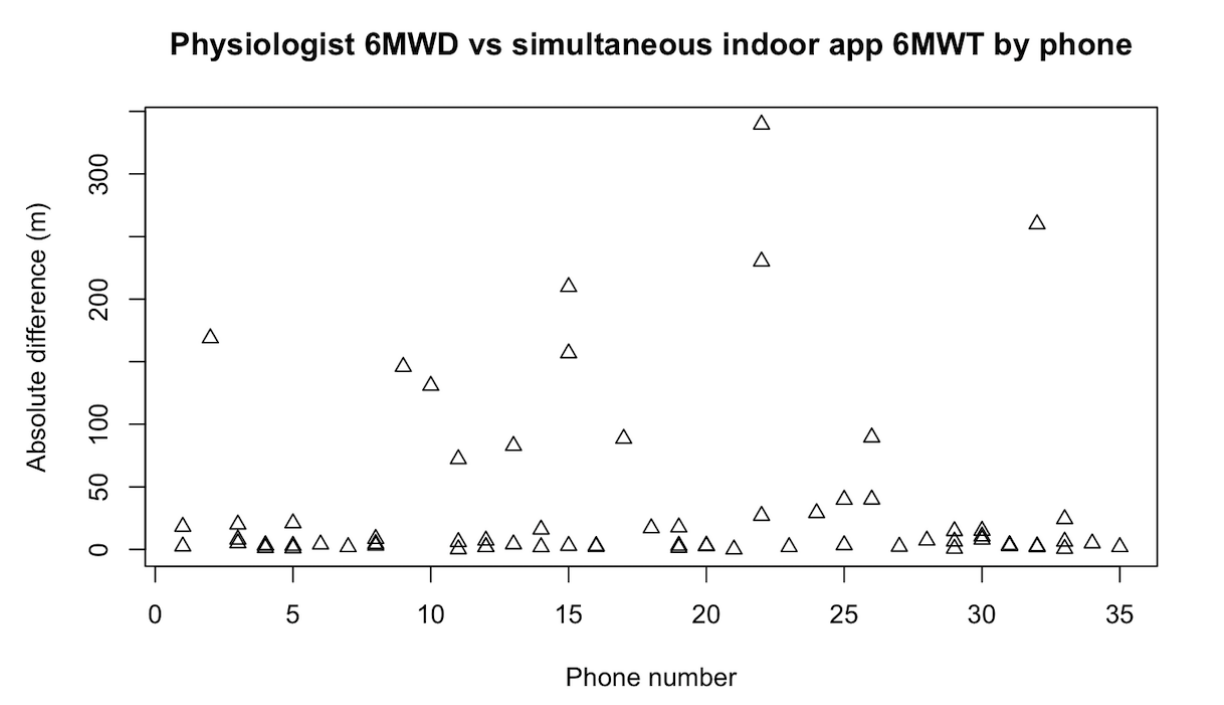
Figure 3. Absolute difference of the 6-minute walk test distance as measured by the physiologist and as measured by the mobile phone app in indoor mode. 6MWD: 6-minute walk test distance; 6MWT: 6-minute walk